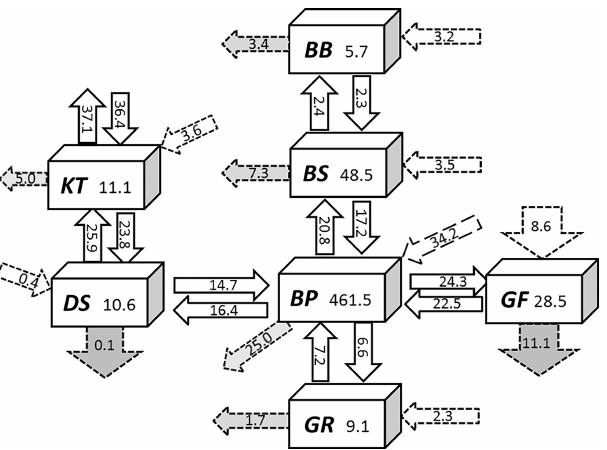
Figure 10. Annual mean total phosphorus budgets of the Baltic Sea averaged for the period 1971–1999. The average total amounts are inkt, and transport flows and sink/source fluxes (external nutri- ent inputs/sink) are in ktyr − 1 . External nutrient inputs from atmo- sphere and land are combined.